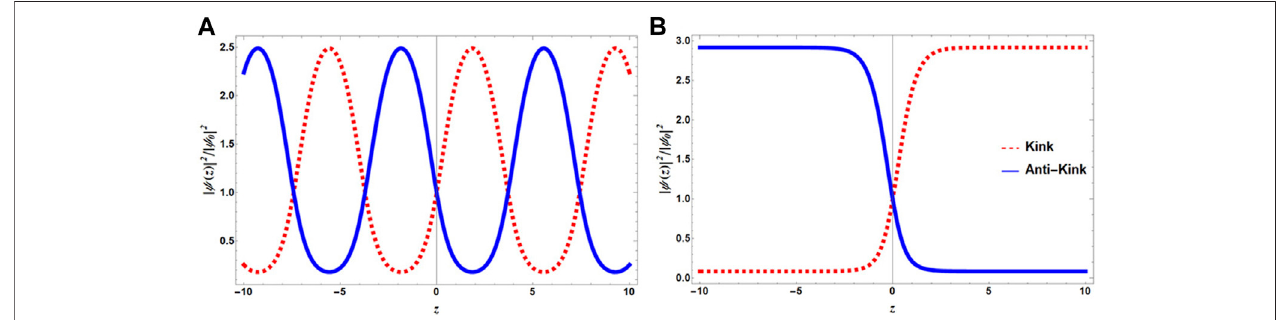
FIGURE6| (ColorOnline)Thebehaviorof “ sn ” solutionaccordingto Eq.25 fordifferent q . (A) Theperiodicspatialdensityvariationfor q =1/2. (B) Kinkandantikink type pro fi les are reported for q = 1. In both fi gures, the red dashed line depicts ψ + ( z ) solution and the blue solid line corresponds to the ψ − ( z ) solution. The density distribution is again normalized by | ψ 0 | 2 .